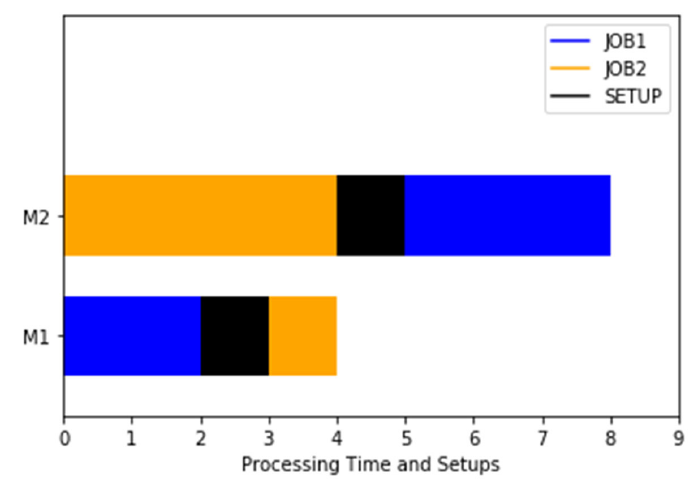
Fig. 2. Solution with distinct